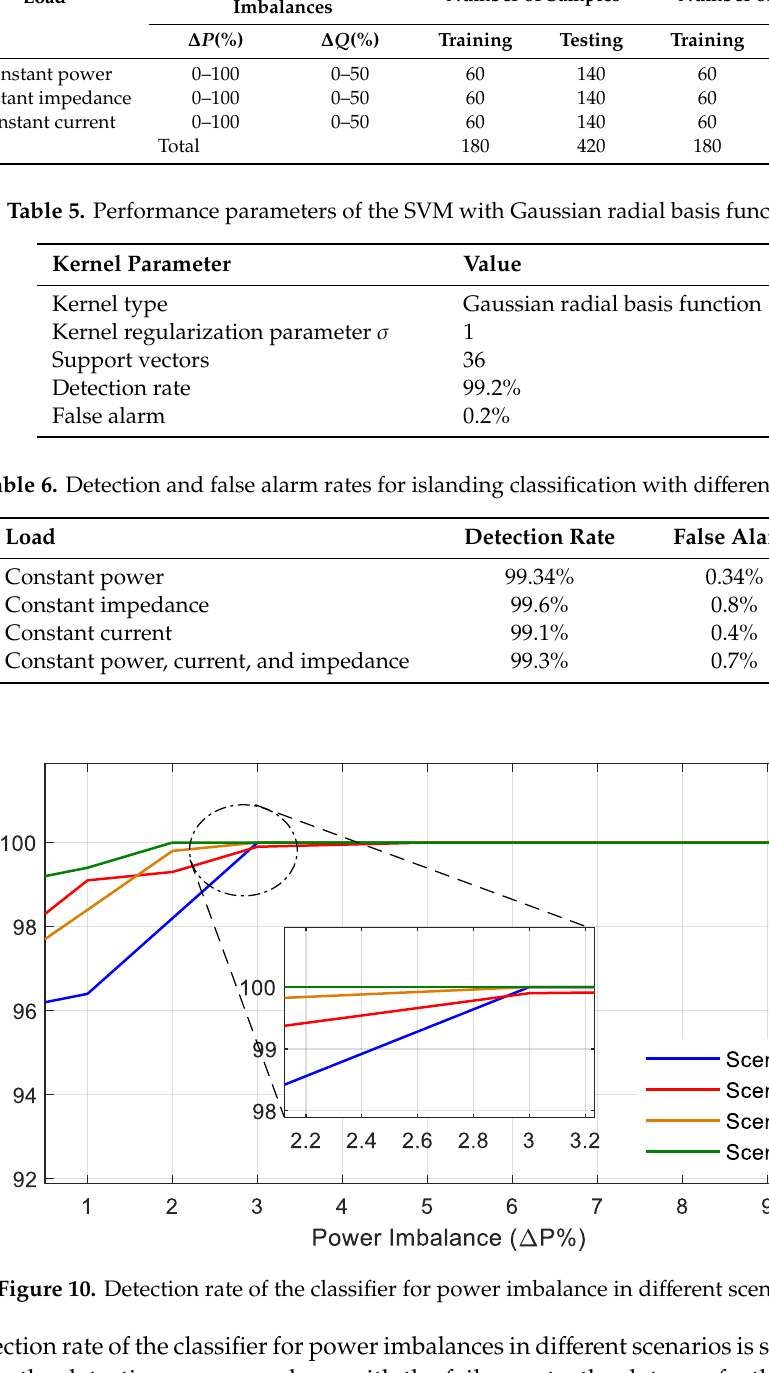
Table 5. Performance parameters of the SVM with Gaussian radial basis function.